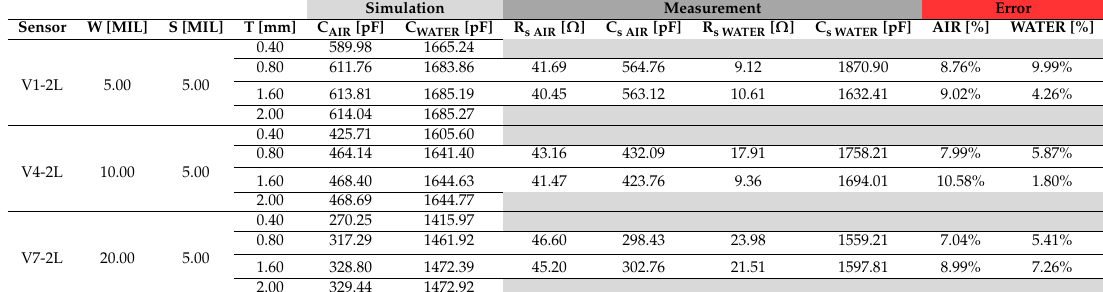
Table 4. Simulation and measurement results for the structures designed on variable thickness PCB. The environment is air ( (cid:101) r = 1) or distilled water ( (cid:101) r = 77). Variants with grayed-out rows were not